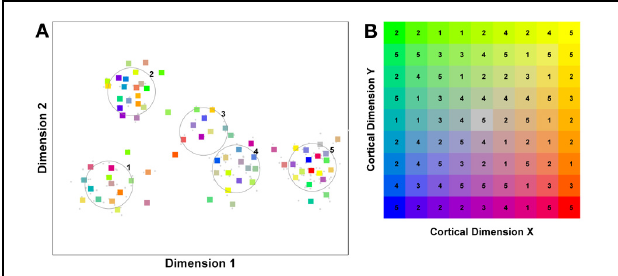
FIGURE 12 | Selectivity preferences for 81 neurons exposed to five object categories containing 50, 40, 20, 50, and 100, exemplars, respectively. No lateral interaction between classifiers. (A) Each colored square represents a classifier whose color encodes its relative position across the 2D surface of cortex. The five circles represent the extent of the five object categories. (B) The color-based encoding of classifier location in cortex. Blue and yellow represent points on the cortical surface that are far apart, as do red and green. Physically proximity is conveyed by the change in color (hue). The number appearing on top of each neural classifier represents the object category for which that particular neuron is selective. Notice in this case that there is no evidence of any structure in the neural selectivity, i.e., there is no link between category and the physical location in cortex of the neuron.